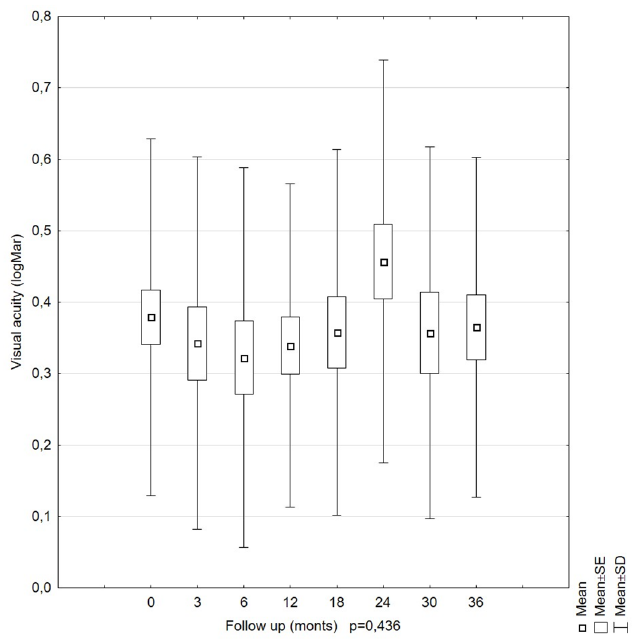
Figure 7. Mean best corrected visual acuity (BCVA) values in LMH patients during the 36-month follow-up period. The BCVA remained stable over the entire follow-up period.